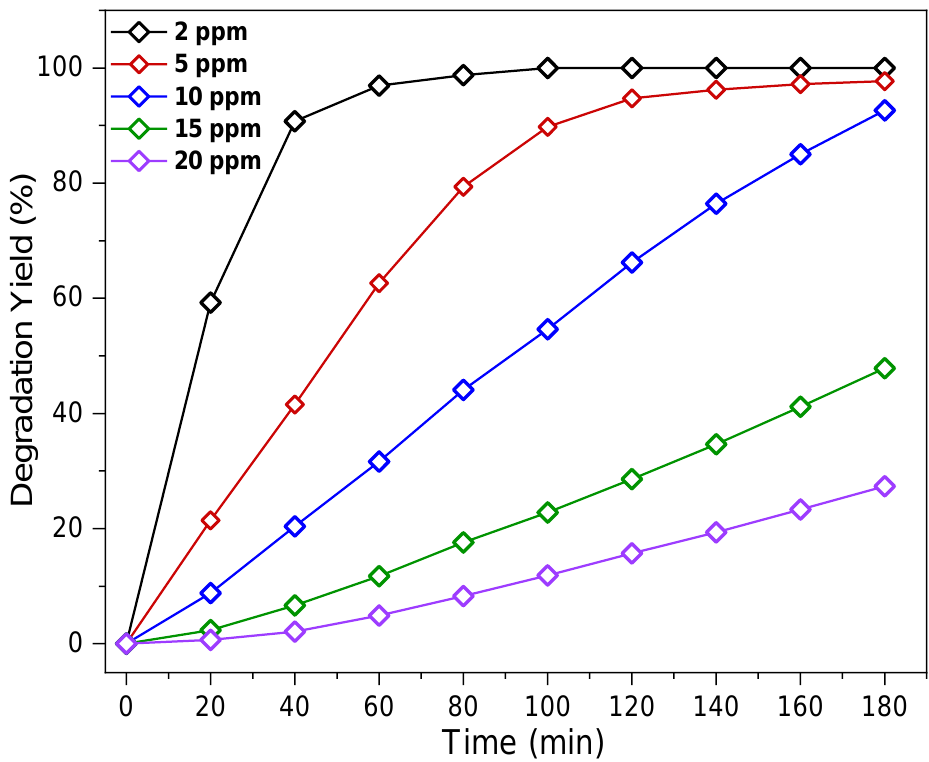
Figure 7. Effect of initial dye concentration with 500 mL of BPB solution, 100 mg/L of catalyst, natural pH, under UV irradiation.